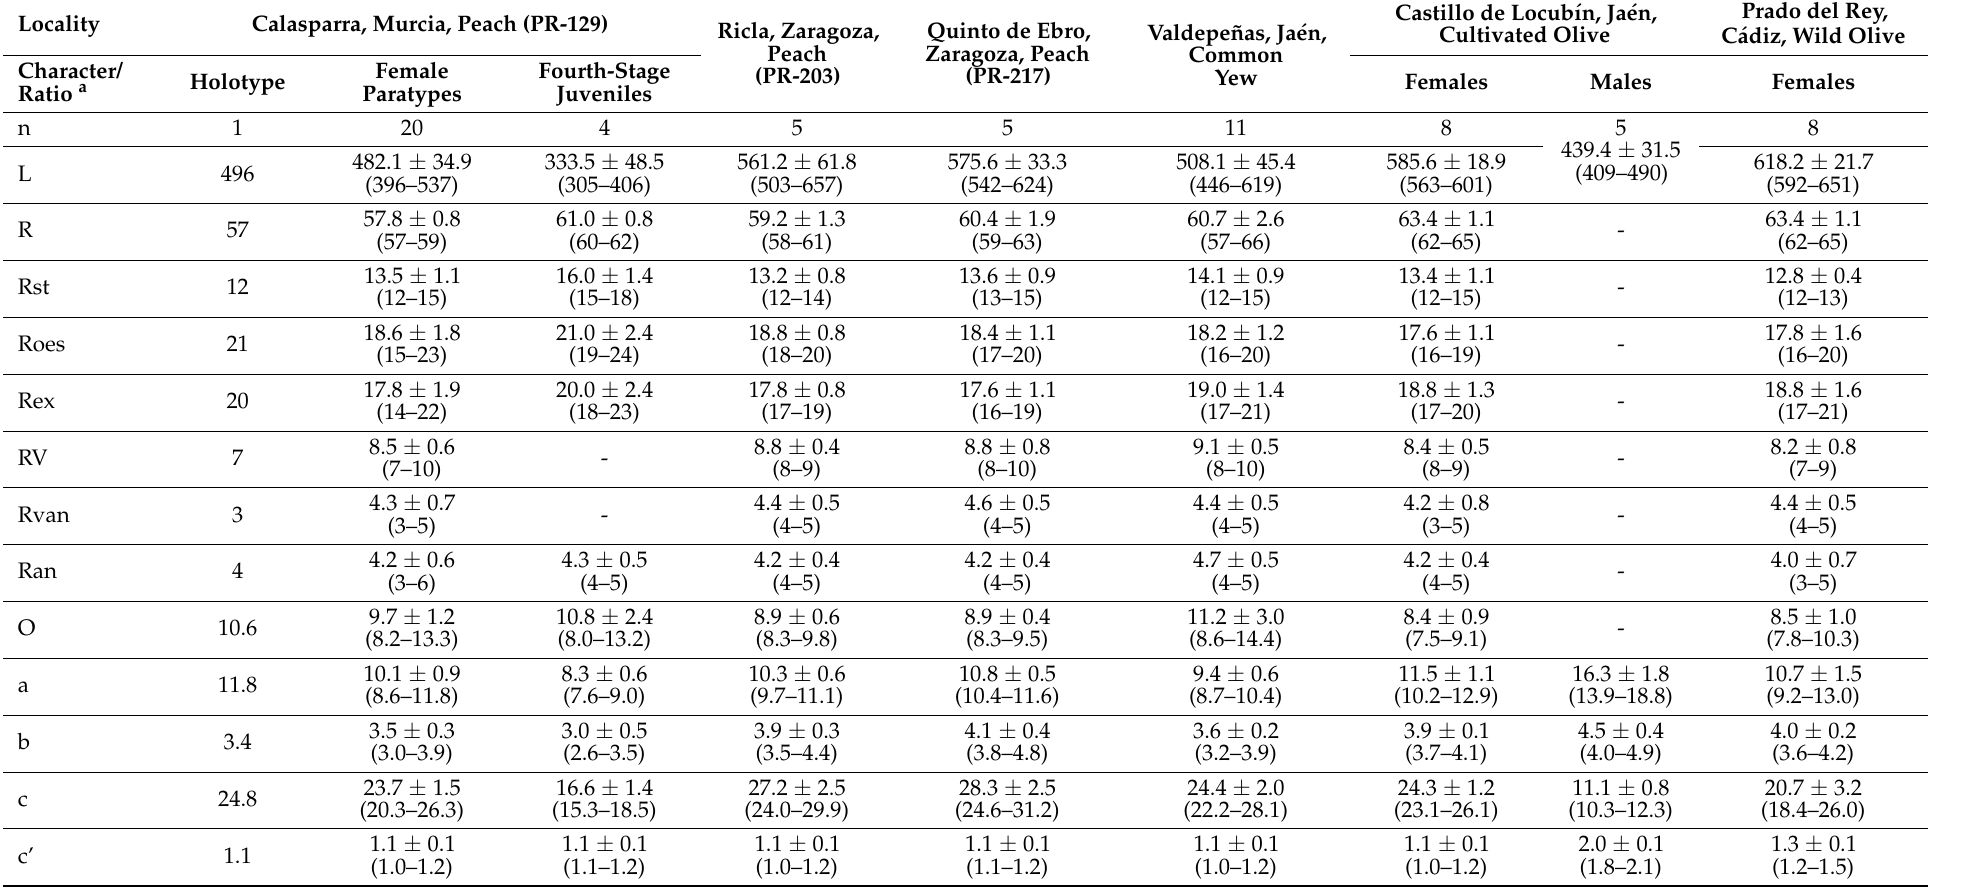
Table 4. Morphometrics of Criconema paraannuliferum sp. nov. from several localities in